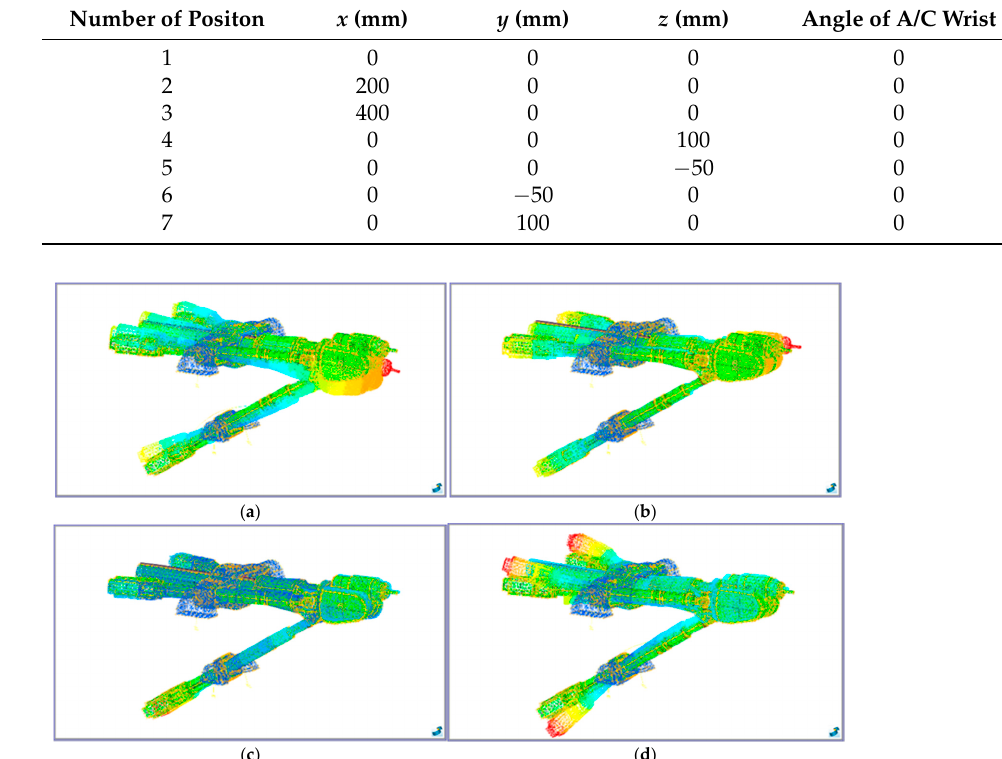
Figure 4. The natural frequency simulation values of the PKM at position 7. 2.2. Cutting Forces Modeling and Identification of Cutting Forces Coefficients of Helical Milling Based on PKM In order to analyze the 3-DOF cutting stability of helical milling, the cutting forces of the helical milling based on PKM will be established first in this section. Both the side and the bottom edges of the tool are involved in the cutting process. The working state of the side edge can be approximated as an ordinary milling process, while the working state of bottom edge can be approximated as a drilling process. Therefore, the feed motion of hel- ical milling can be divided into two parts, which are axial feed motion v c and circumfer- ential feed motion n c . The feed trajectory is a spiral line, whose radius is the eccentric dis- tance e of the tool and the hole, the pitch is the axial feed a p per revolution, the spindle speed is n , and the number of tool edges is N . The schematic diagram of cutting thickness of helical milling is shown in Figure 5.